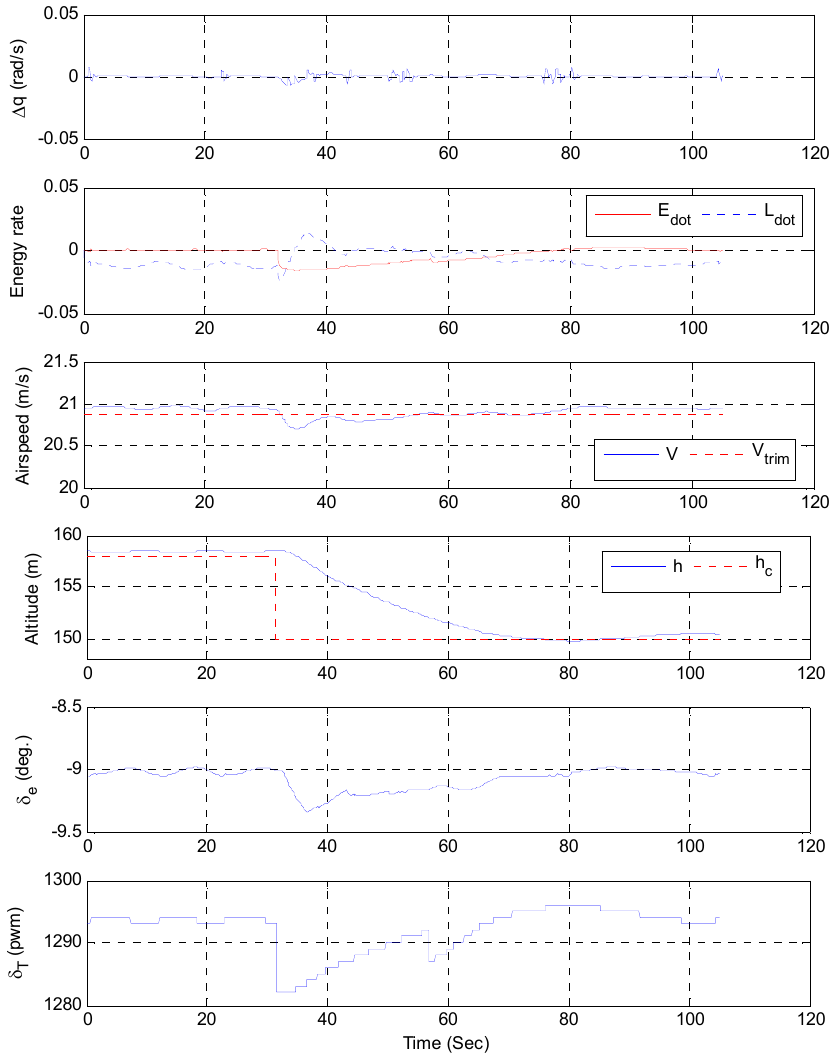
Figure 17. Both the change of pitch rate, ∆(cid:1869) , and (cid:1838)(cid:4662) (cid:2929) are regulated within ±0.01 rad/s and ±0.02 , respectively. The aircraft descended from 158 to 150 m in around 40 s, while maintaining the airspeed within ±0.2 m/s from trim airspeed. For the simulation results of aircraft descend with the presence of wind, as shown in Figure 18, the errors of ∆(cid:1869) , (cid:1838)(cid:4662) (cid:2929) , airspeed, altitude, and altitude tracking settling time are almost the same as the aircraft climb maneuver.